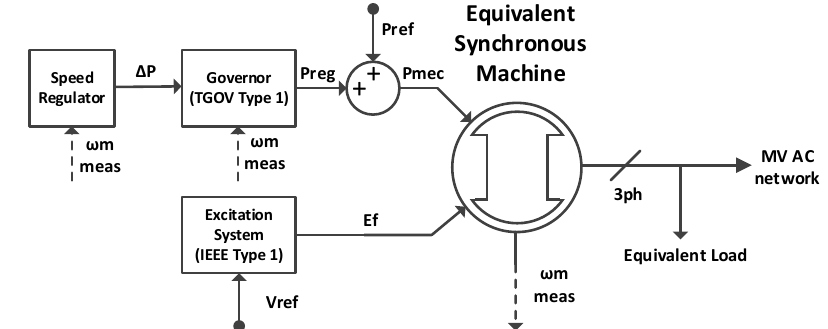
Figure 10. Equivalent computational model for the Upstream AC power